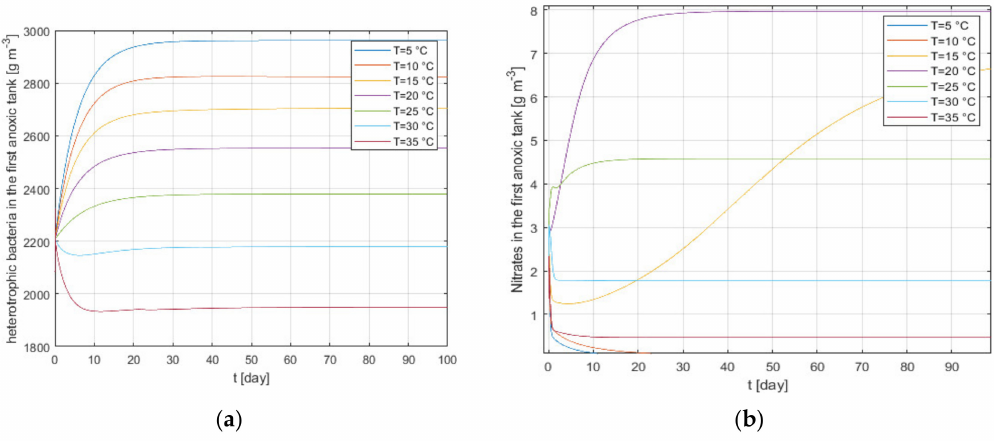
Figure 9. Heterotrophs ( a ) and nitrates ( b ) in the first anoxic tank for di ff erent temperature